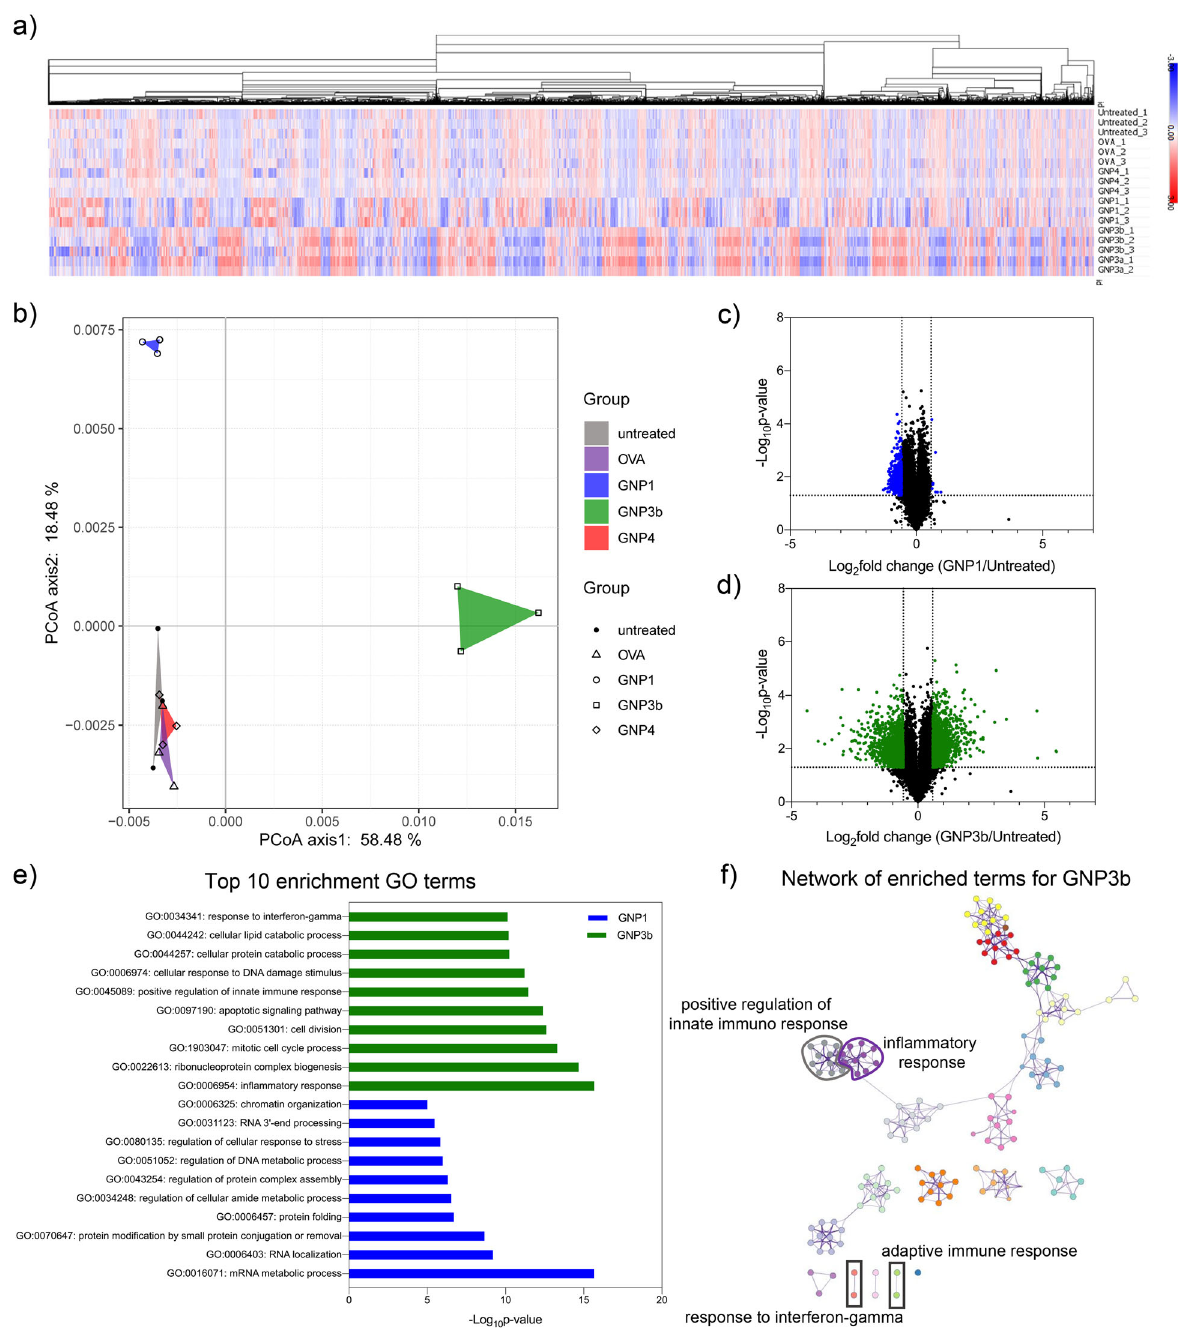
Fig. 4 Transcriptome analysis for shape-dependent biological responses in murine dendritic cell line JAWS II. The cells were treated with GNPs for 24h. a Heatmap of genes identi fi ed in the microarray. Z-score hierarchical clustering based on Euclidean distance and average linkage. b Principal coordinate analysis (PCoA) illustrating the difference in transcriptome between treatment groups. The PCoA was conducted using Bray-Curtis dissimilarity matrices. c , d Volcano plot showing differentially expressed genes in comparison to untreated cells after incubation with GNP1 ( c , in blue) and GNP3b ( d , in green). e Gene ontology (GO) enrichment analysis for differentially expressed genes by Metascape. Bar graph showing top ten GO terms (biological process aspect) for GNP1 and GNP3b. f Network enrichment analysis by Metascape. Each term represents a node and colored by its cluster. Terms with similarity score >0.3 are linked by an edge, and the thickness of the edge represents the similarity score. The immunological response-related clusters impacted by GNP3b are